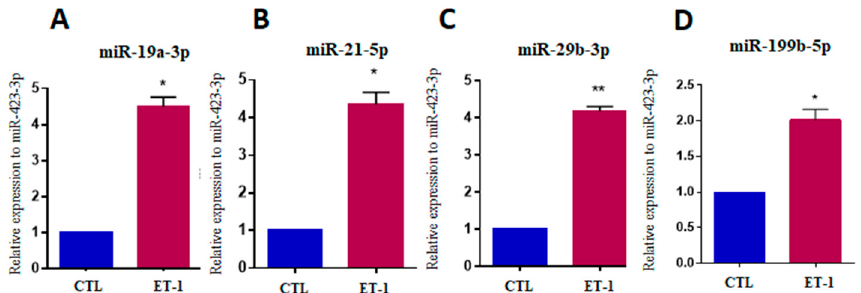
Figure 6. Increased miRNA expression after hypertrophic stimulus with endothelin-1 in hiPSC-CM. Expression levels of miR-19a-3p ( A ), miR-21-5p ( B ), miR-29b-3p ( C ) and miR-199b-5p ( D ) in hiPSC-CM stimulated with ET-1, evaluated by RT-qPCR. CTL = unstimulated hiPSC-CMs, ET1 = hiPSC-CMs stimulated with ET-1. Values represent the mean ± SEM of n = 3 per group. Data were analyzed using Student’s t -test. * p < 0.05; ** p < 0.01.